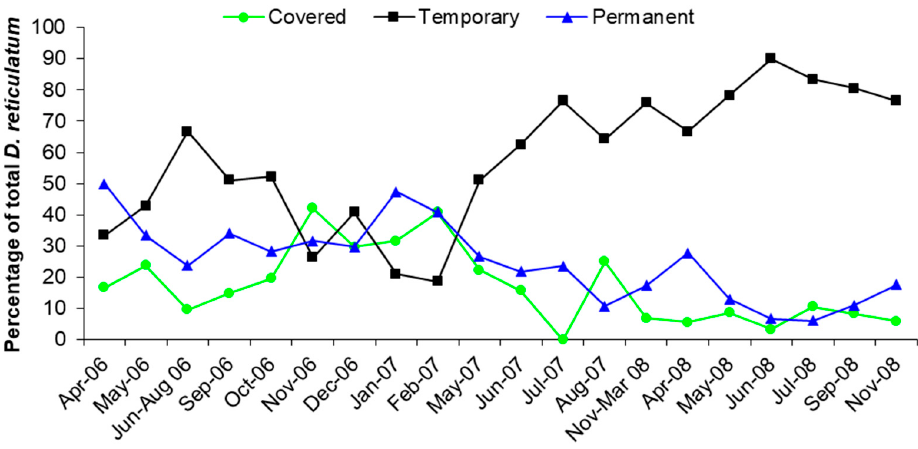
Figure 3. The percentage of the total Deroceras reticulatum numbers for each sampling period found in each trap type. Comparing the total numbers of D. reticulatum collected in the different trap types in